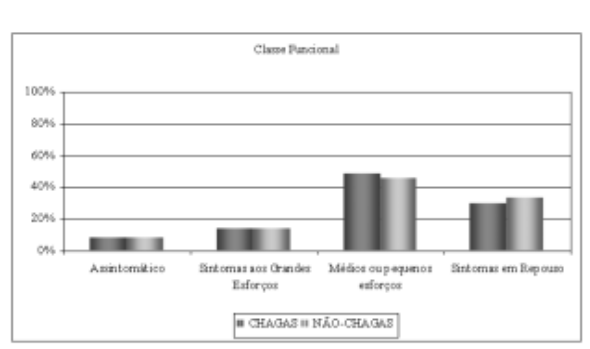
Fig. 3 - Classe funcional dos pacientes para insuficiência cardíaca nos implantes iniciais